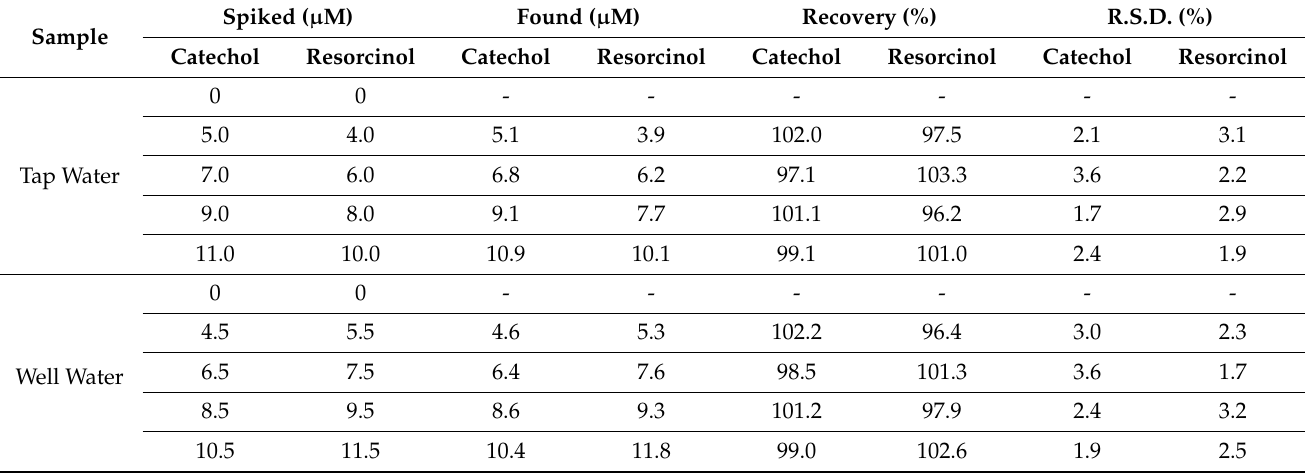
Table 1. Results of determination of catechol and resorcinol in real samples (tap water and well water) using